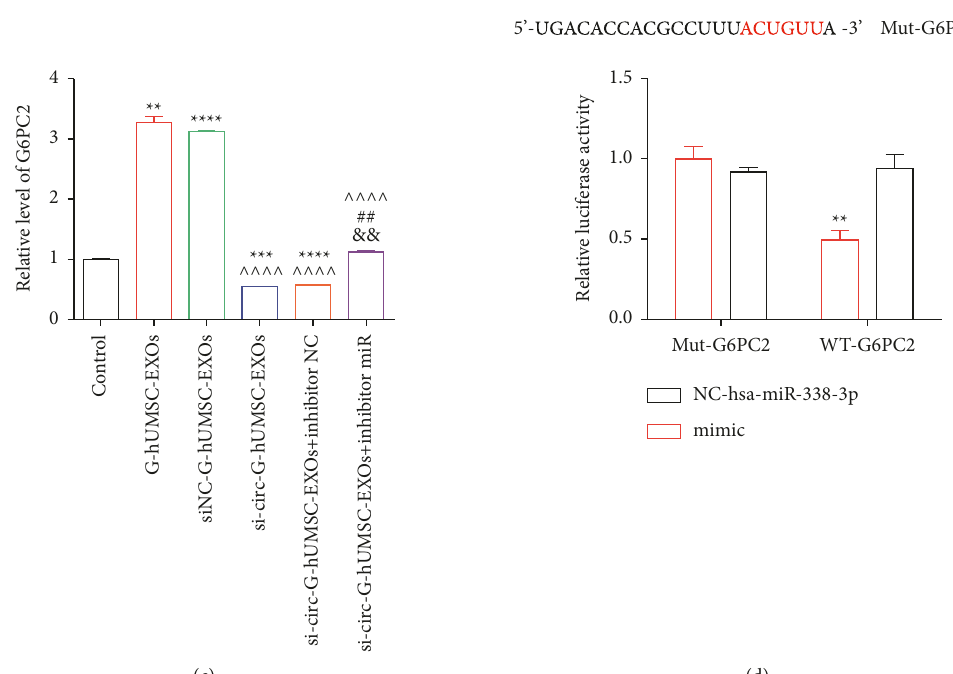
Figure 5: Hsa-miR-338-3p was directly bound to hsa_circ_0046060 and it regulated G6PC2 expression. (a) hsa-miR-338-3p targets the 3 UTR sequence of hsa_circ_0046060. Luciferase reporter assay was performed to verify the interaction between hsa_circ_0046060 and hsa- miR-338-3p in L-02 cells.